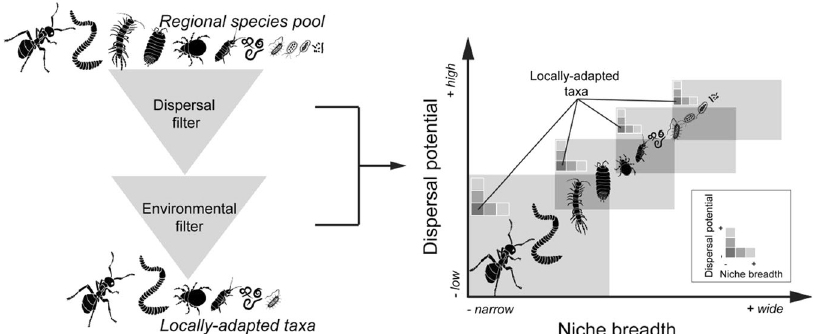
Fig. 1 Conceptual fi gure of soil biota at higher taxonomic levels within which the size of soil organisms tends to increase in relation with their dispersal potentials and niche breadths. Regional species pools may be reduced into taxa that can only occur at a particular site (local communities) through dispersal and environmental fi lters ( left panel ). Taxa that simultaneously occupy a narrow niche breadth and exhibit low dispersal potential could be de fi ned as the locally-adapted taxa. Dispersal abilities should be lower for the larger than the smaller organisms as a result of greater metabolic plasticity and greater environmental tolerance of the later. Smaller soil biota should occupy a wider niche breadth because they are easily dispersed ( right panel